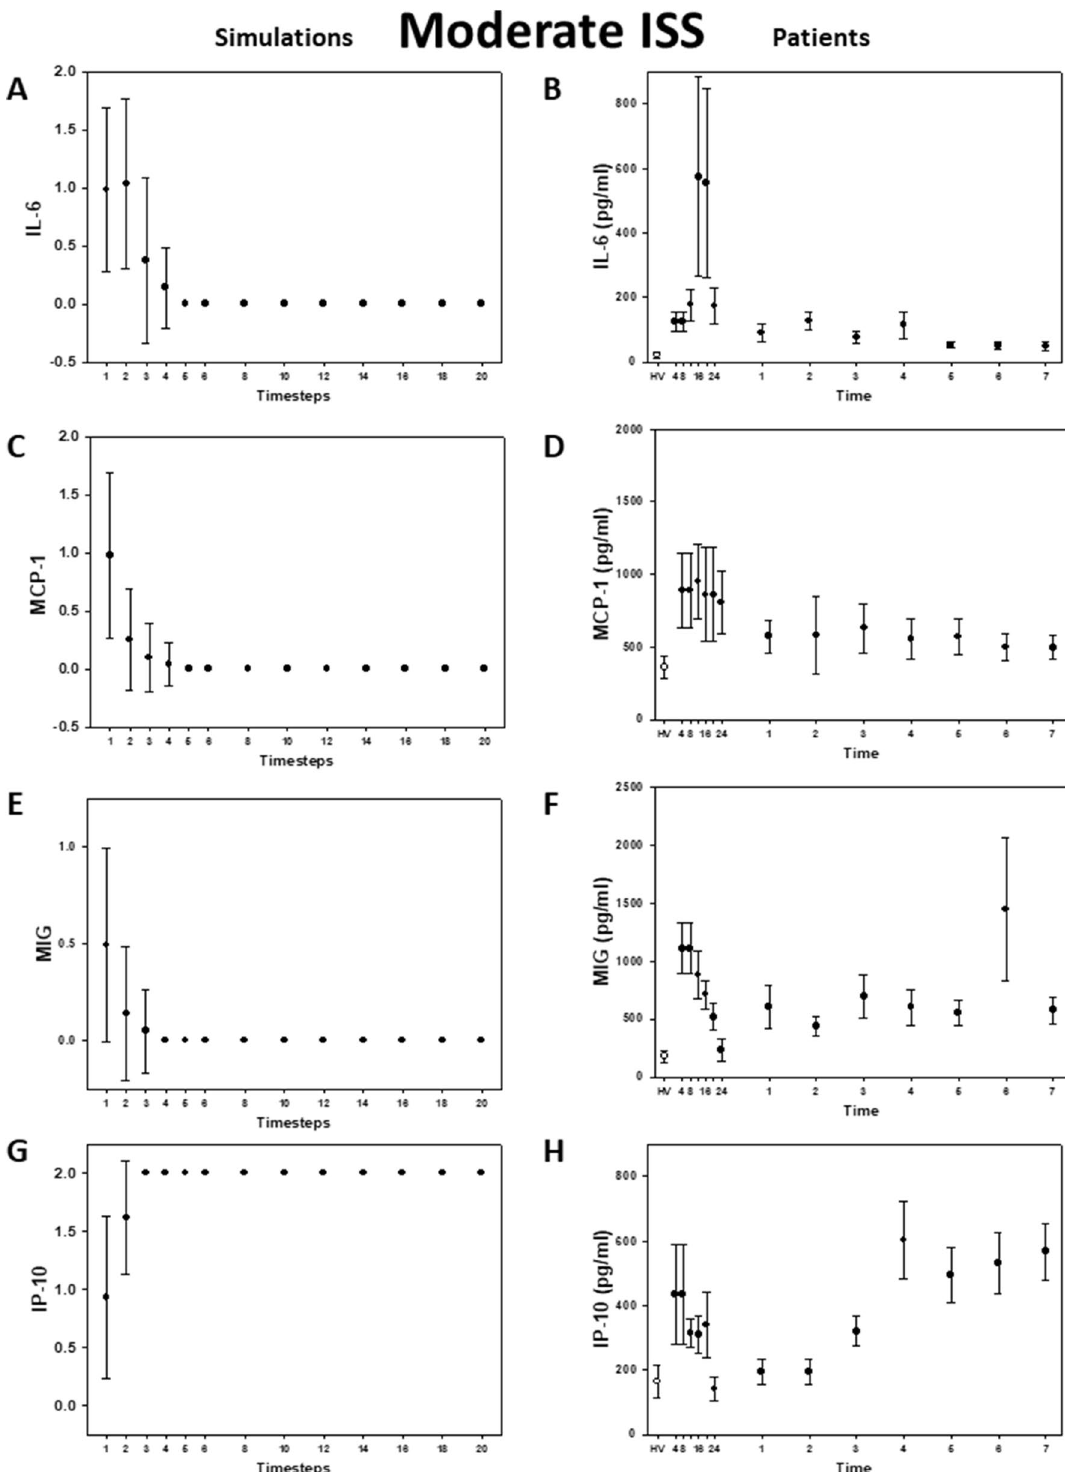
Figure 2. Inflammatory mediator trajectories for Moderate Injury: Simulations vs. data from trauma patients. Left column: 500 simulations were run with random initial conditions. Plot shows mean plus standard error for each time step. Right column: Patient data shown as mean with standard error for each time point. Healthy volunteer (white circles) included for